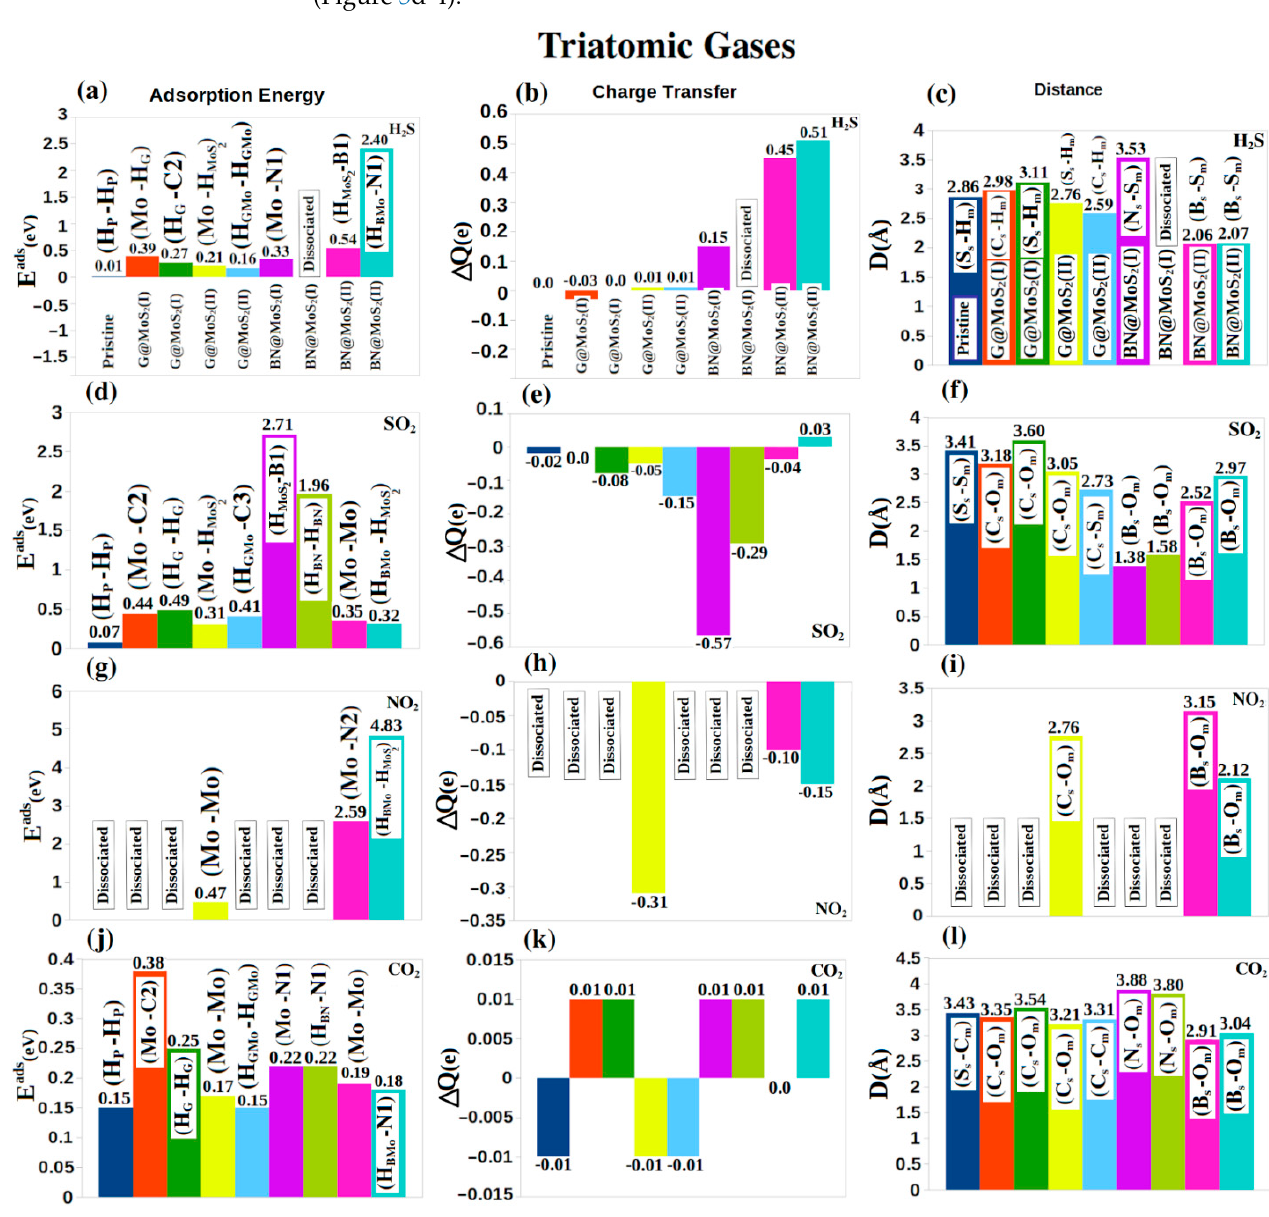
Figure 5. ( a – l ) From left to right, the adsorption energy ( E ad (eV)), charge transfer ( ∆ Q (e)) and the closest distance (D(Å)) between the gas (X m ) and the sheet (X s ) for triatomic gases. From top to bottom H 2 S, SO 2 , NO 2 , and CO 2 gases are considered. The initial and final positions (Y, Z) of the adsorbed gases before and after optimization are shown in the adsorption energy figures (first col- umn).